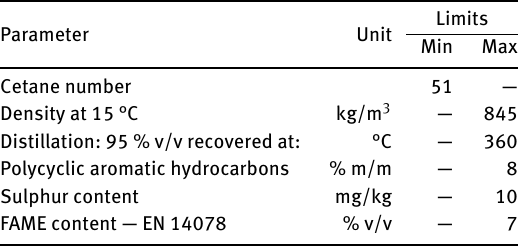
Table 3: Properties of diesel fuels according to EU standards (from transportpolicy.net, 2015 ). The lower heating value and the carbon content are not